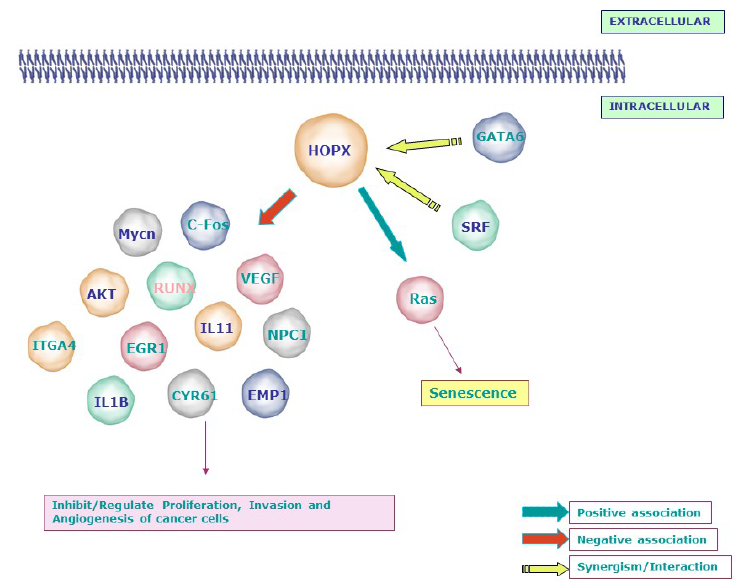
Figure 3. Signaling molecules related to the tumor suppressor function of HOPX: Loss or gain experiments and microarray analyses revealed the negative association between HOPX and molecules involved in invasion, angiogenesis, and transformation, including Mycn, c-Fos, AKT, VEGF, EGR1, IL11, IL1B, and EMP1. In line with its mechanism during development, HOPX affects the proliferation of cancer cells by synergizing with SRF and GATA6. Notably, HOPX induces senescence through the RAS-ERK-MAPK signaling cascade in lung cancer. SLC2A3—Solute Carrier Family 2 (Facilitated Glucose Transporter), Member 3; NPC1—Niemann–Pick disease, type C1; RUNX1—Runt-related transcription factor 1; CNN1/CYR61—Cysteine-rich, angiogenic inducer, 61; WTAP—Wilms tumor 1-associated protein; PRDX2—Peroxiredoxin 2; EREG—Epiregulin; ITGA4—Integrin, alpha 4; EMP1— Epithelial membrane protein 1; EPHA2—EPH receptor A2; EGR1—Early growth response; MYCN— v-myc avian myelocytomatosis viral oncogene neuroblastoma-derived homolog; IGFII—Insulin-like growth factor 2 (somatomedin